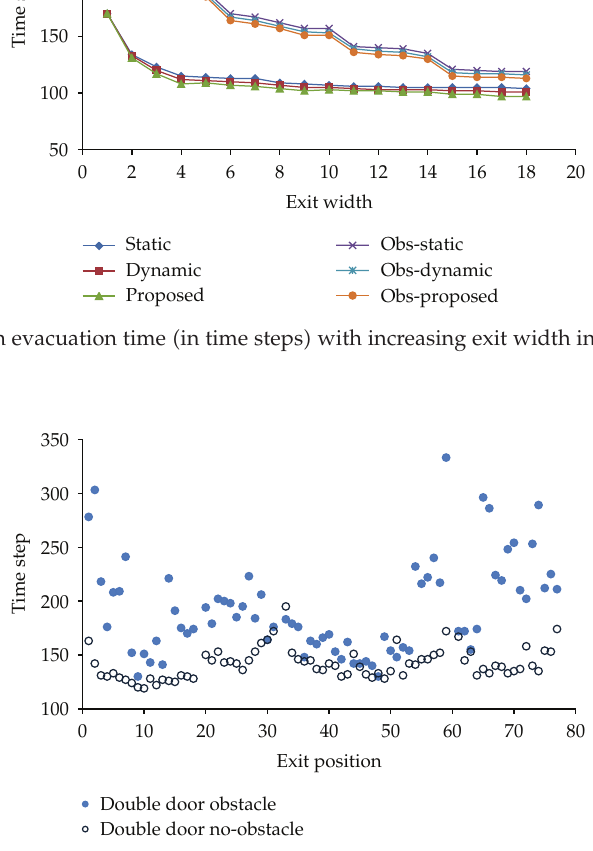
Figure 17: Evacuation time (cid:2) in time steps (cid:3) for di ff erent locations of one double-door exit in the restaurant shown in Figure 12, with (cid:2) filled circles (cid:3) and without (cid:2) open circles (cid:3)